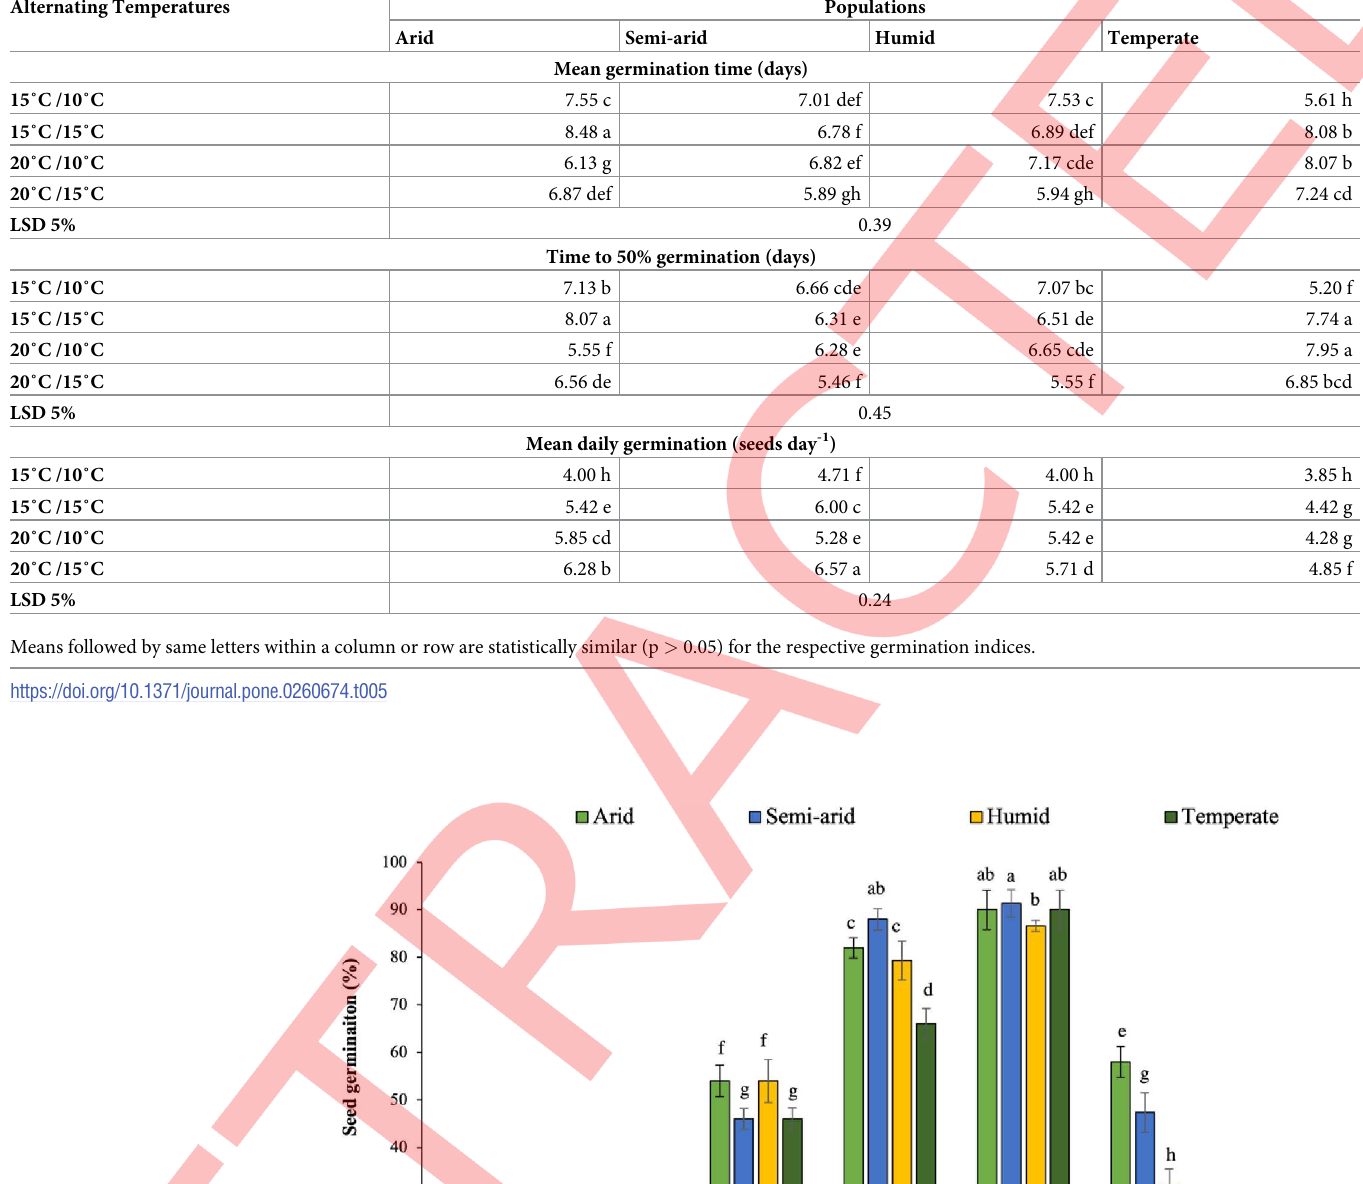
Table 5. The impact of different alternating day/night temperatures on various germination indices of Conyza sumatrensis populations collected from varying cli- matic regions.